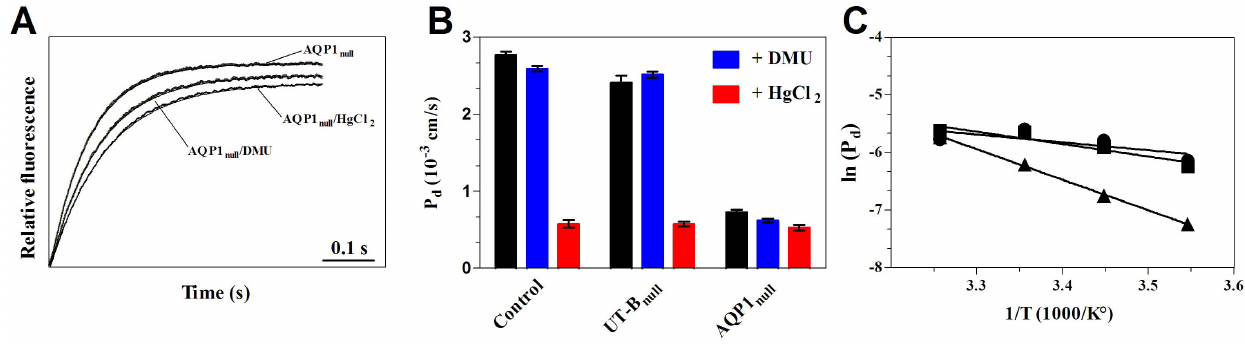
Figure 2. Diffusional water permeability of RBCs. (A) Time course of the diffusional water permeability at 15 u C in ghost from AQP1 null phenotype, in the presence or absence of HgCl 2 (10 mM) or DMU (0.5 mM). Smooth lines are exponential fits to the data using the simplex procedure of the Biokine (Bio-logic), providing rate constant of water permeability k (s 2 1 ). (B) Coefficients of diffusional water permeability (P d ) at 15 u C in the absence or the presence of inhibitors (Blue, DMU; red, HgCl 2 ). Three experiments for each individual were averaged and the means of the rate constants k (s 2 1 ) for 3 controls, 3 UT-B null and AQP1 null were reported ( 6 SD). (C) Arrhenius activation energies (which correspond to the slope of the plot) of diffusional water permeation across RBC membranes (circles, control; squares, UT-B null ; triangles, AQP1 null